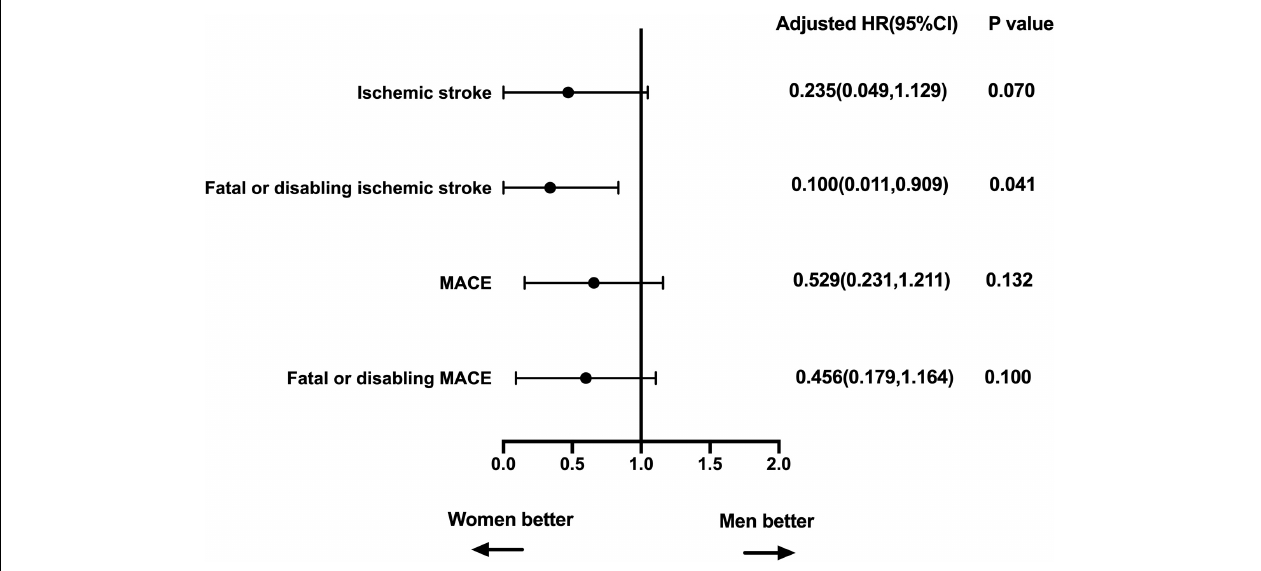
FIGURE 4 | Multivariable-adjusted association of sex and clinical outcomes. Adjusted for CAD, CHA2DS2-VASc, LVEdD, and unsuccessful closure. MACE, major adverse cardiovascular events, including cardiovascular or unexplained death, ischemic stroke or major bleeding; HR, hazard ratio; CI, confidence interval; CAD, coronary artery disease; LVEdD, left ventricular end diastolic diameter.